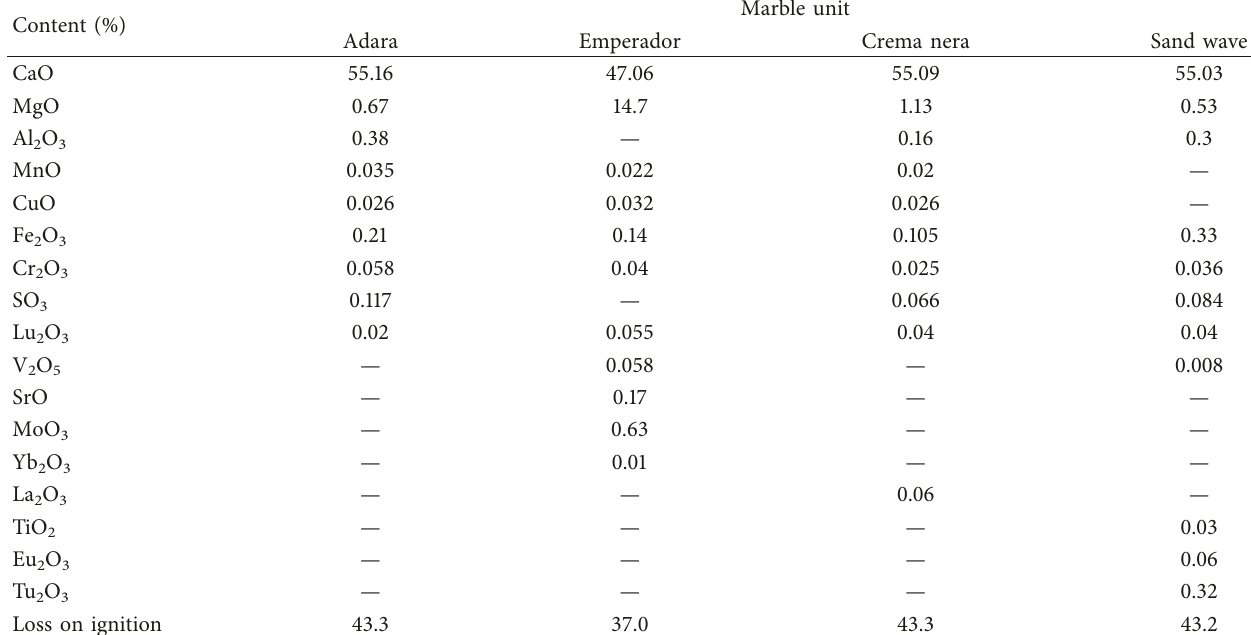
Table 2: Results of XRF semiquantitative analysis.